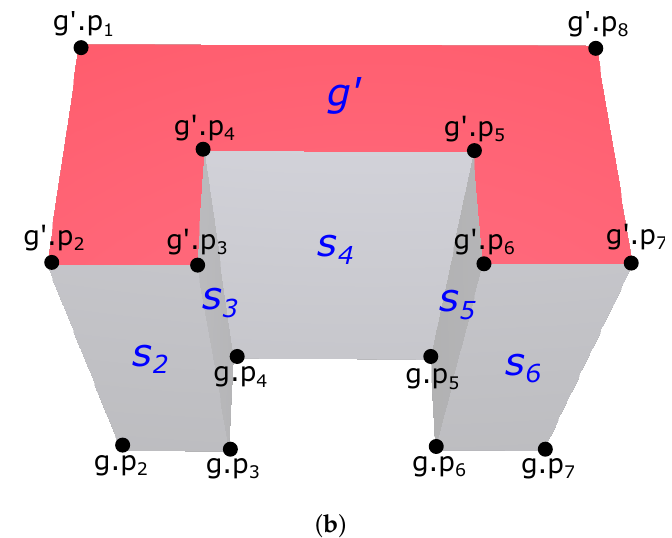
Figure 2. For a building outline ( a ) a base model is generated ( b ), where visible faces and points are marked.